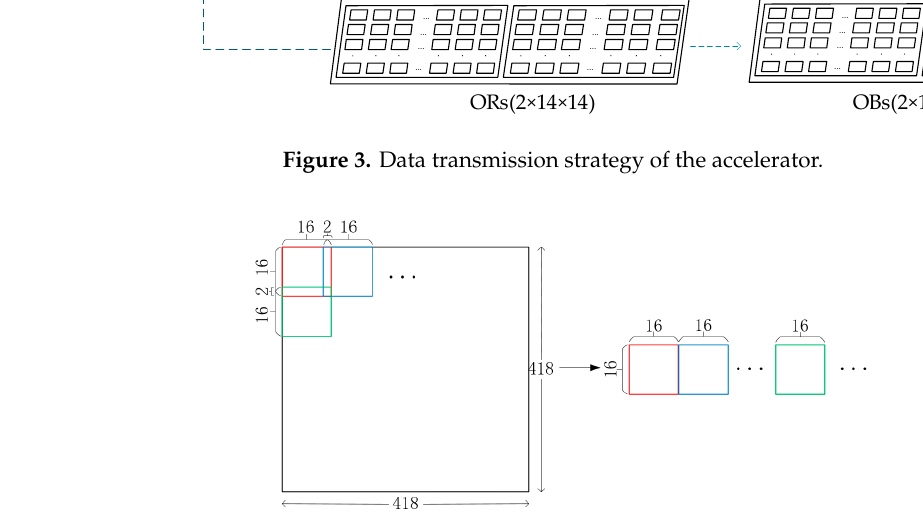
Figure 4. Data block transmission of 3 × 3 convolution, S = 1.